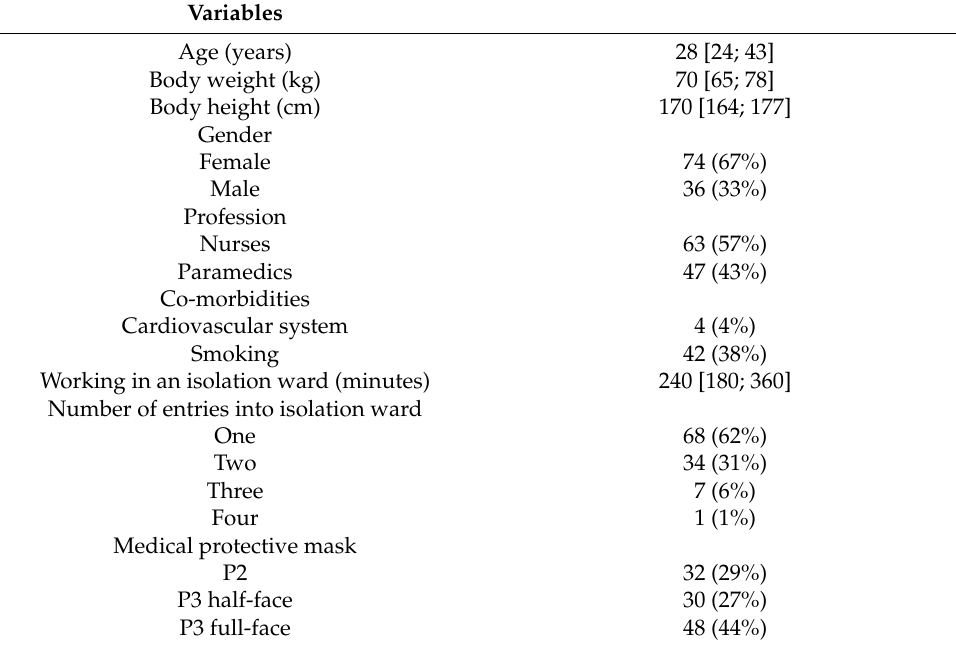
Table 1. Characteristics of participants (n = 110).